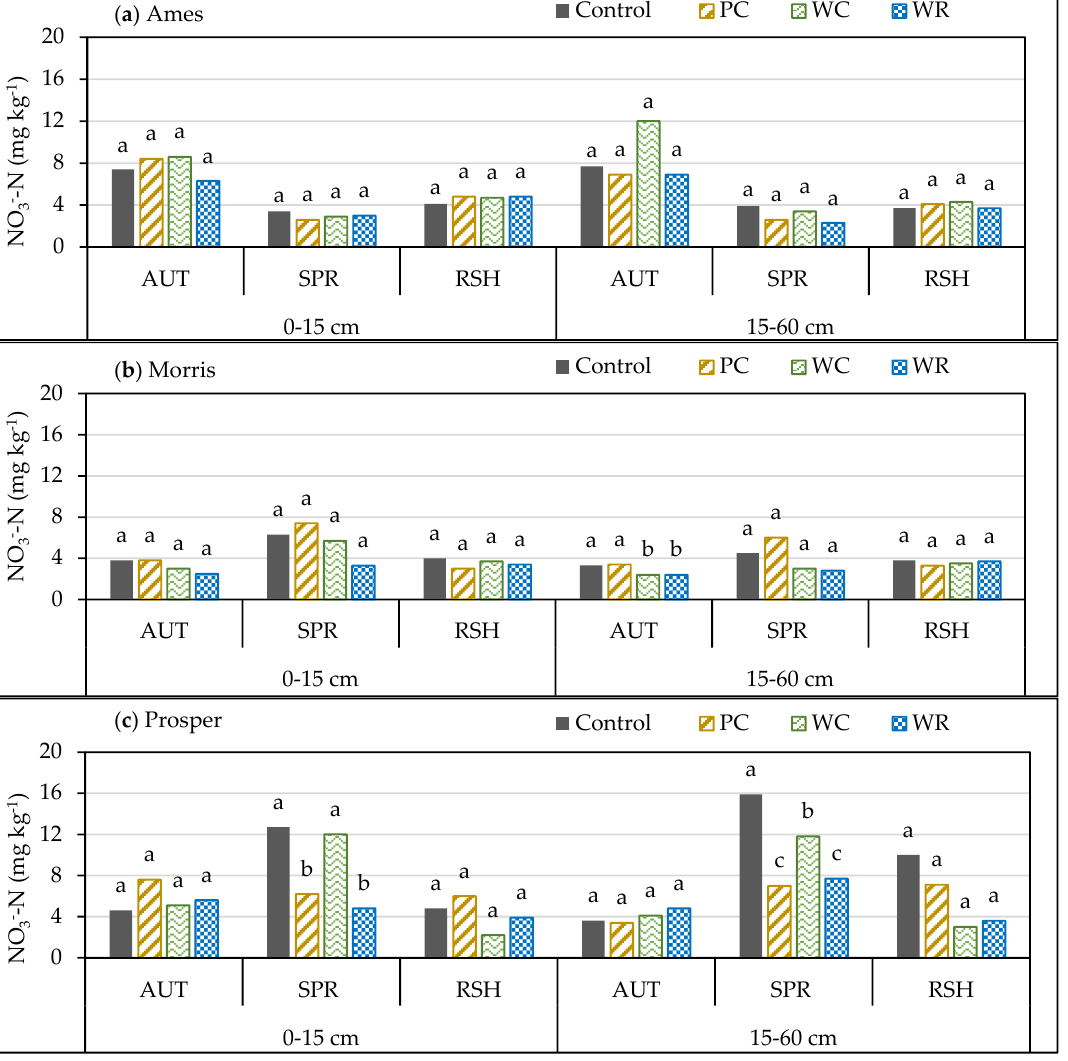
Figure 2. Mean soil NO 3 − -N (mg kg − 1 ) at 0–15 cm and 15–60 cm soil depths for control (no-cover crop), pennycress (PC), winter camelina (WC), and winter rye (WR) when cover crops were interseeded in standing maize at ( a ) Ames, ( b ) Morris, and ( c ) Prosper. AUT = soil samples taken in autumn; SPR = soil samples taken in spring; RSH = soil sample taken immediately following relayed soybean harvesting. Means with the same letter under same soil depth and same season at a location were statistically the